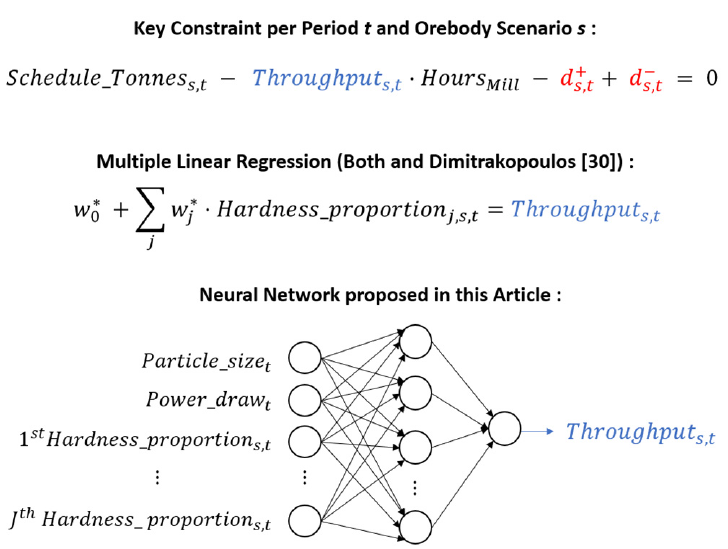
Figure 10. Comparison of models for ball mill throughput prediction and integration into short-term production scheduling.